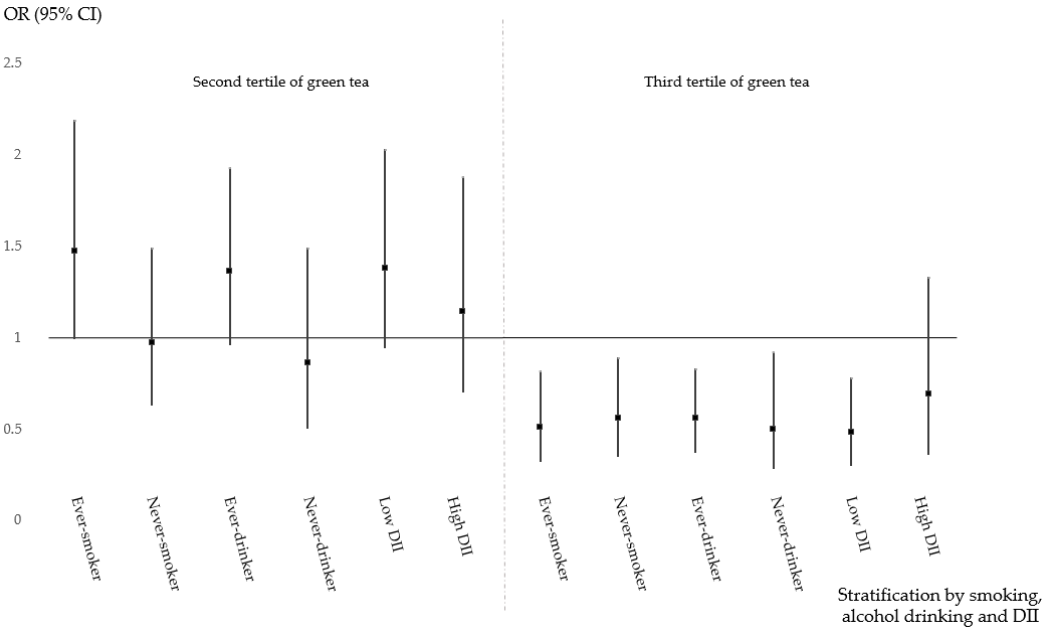
Figure 2. Green tea consumption and the risk of colon cancer stratified by demographic characteristics.